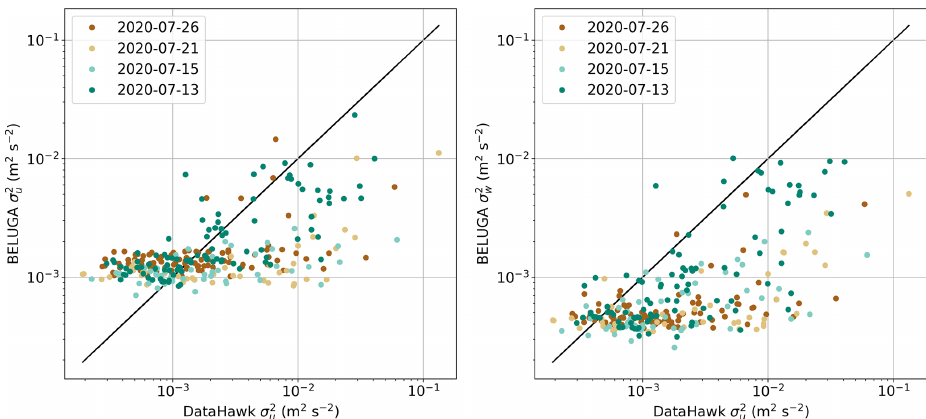
Figure 6. As in Fig. 4 but for variances from DH2 and BELUGA.